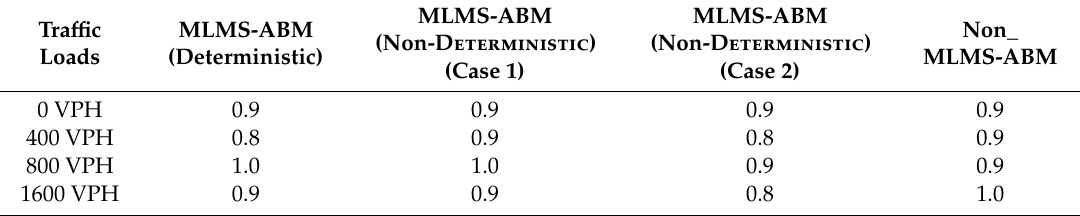
Table 2. Comparing the total travel time for the hypothetical road network and the I-25 road network.